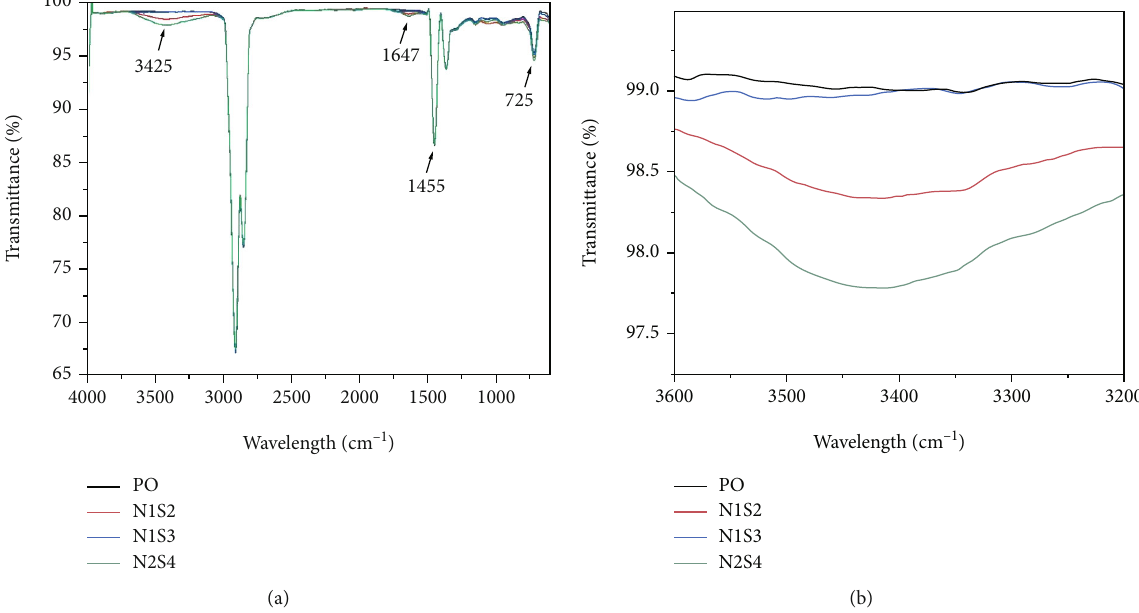
Figure 3: FTIR spectra of PO and biolubricant with (a) complete spectrum and (b) sections of the hydroxyl